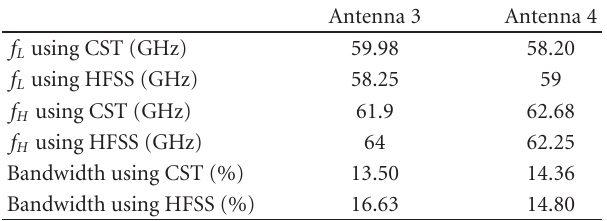
Table 2: Comparisons of the results of antenna 5 and antenna 8 obtained with HFSS and CST.